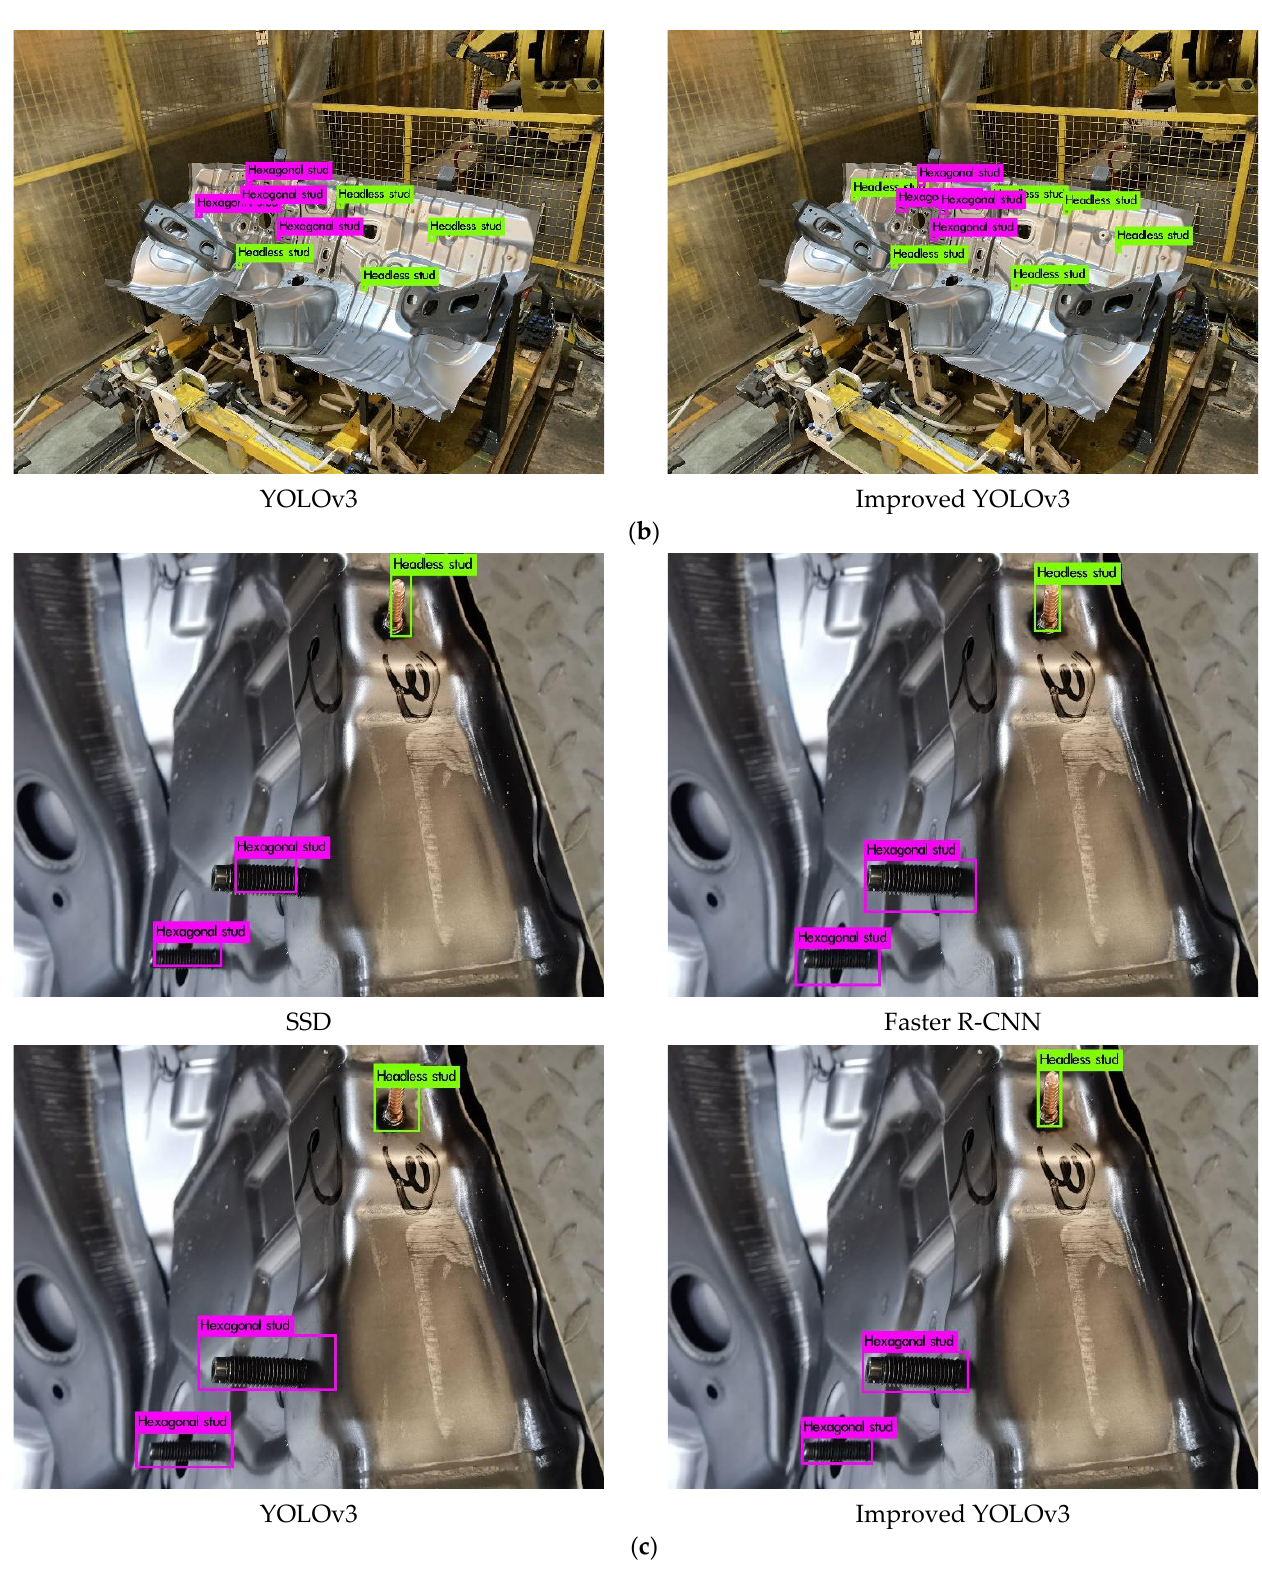
Figure 8. Comparison of partial target detection results of the four models on three images.(a) Close distance detection; (b) long distance detection; (c) IOU comparsion